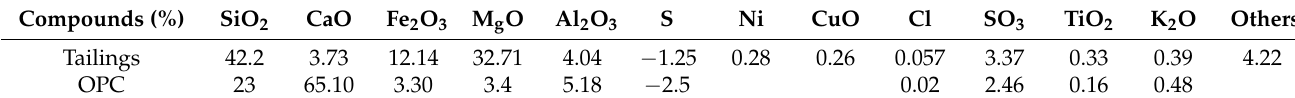
Table 2. Chemical characteristics of tailings and ordinary Portland cement.